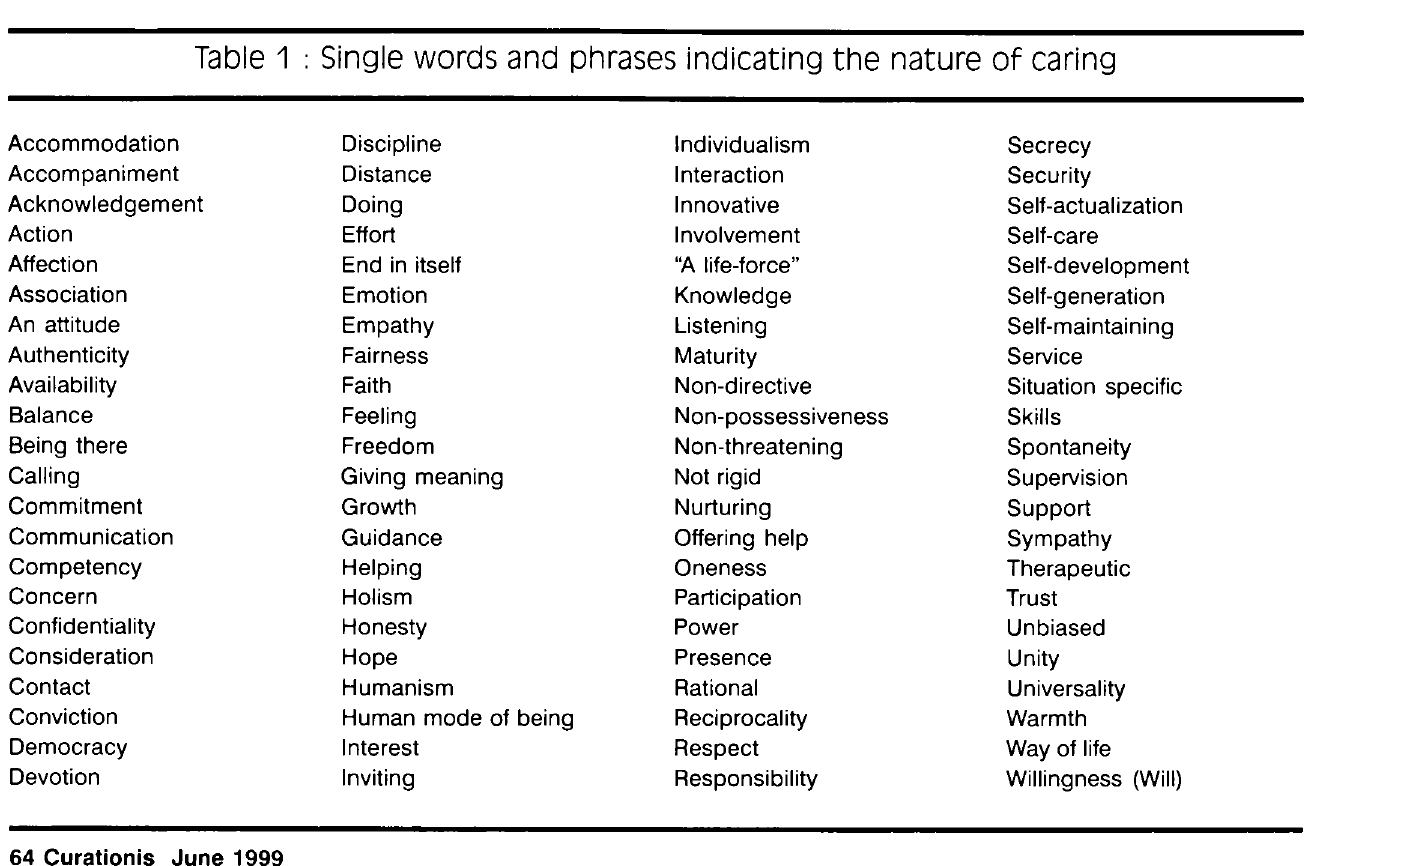
Table 1 : Single words and phrases indicating the nature of